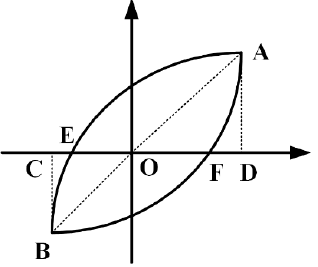
Figure 16. Schematic diagram of E e and ζ e .